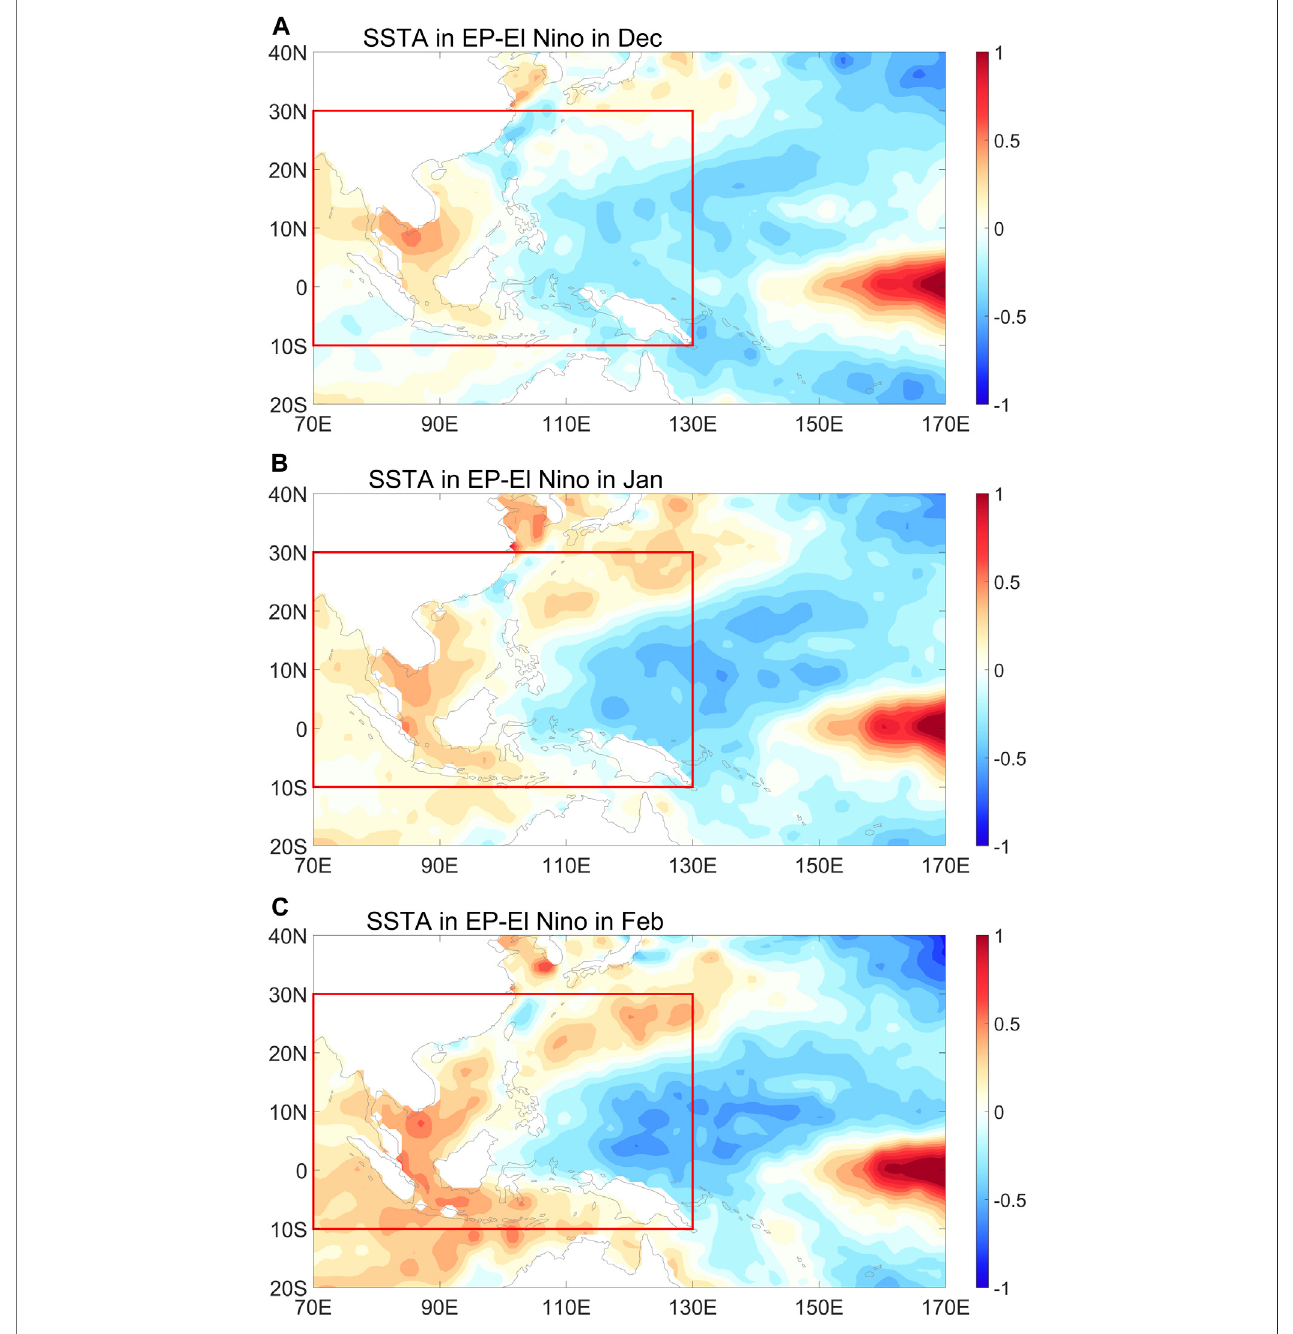
FIGURE 4 | SST anomalies (units: k ) during El Niño mature phases in (A) December, (B) January, and (C) February. The red box indicates the study area.